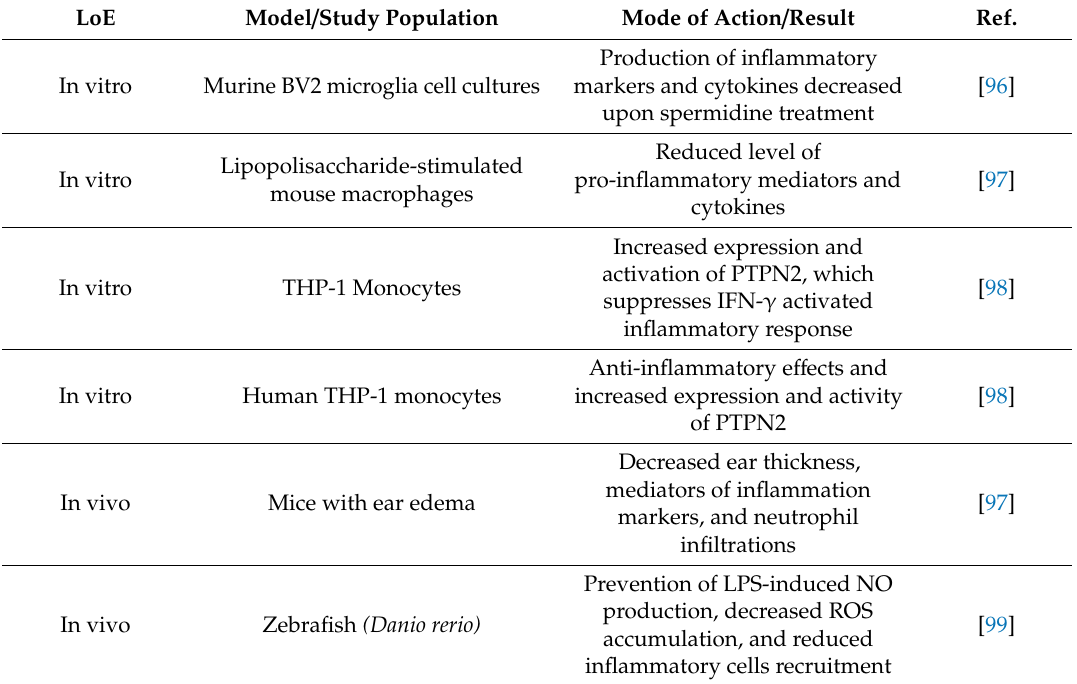
Table 3. Anti-inflammatory e ff ects of spermidine in various